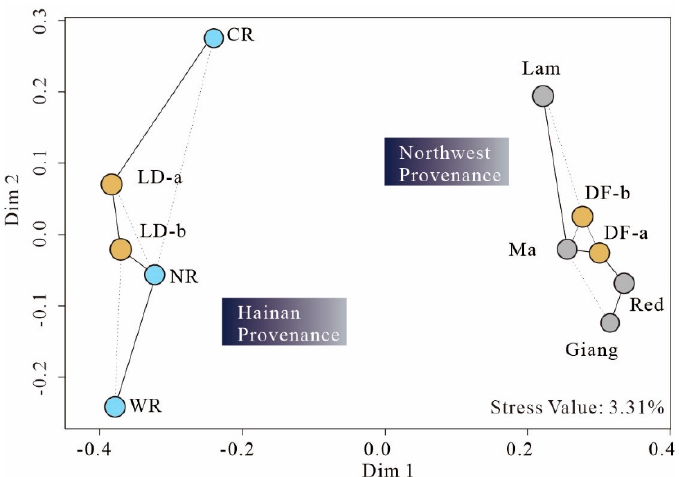
Figure 8. Multidimensional scaling (MDS) plot of detrital zircon U-Pb ages in river and study block sediments. The distance between samples was positively correlated with the Kolmogorov–Smirnov dissimilarity of their dating data. The solid lines connect the nearest neighbors, and the dotted lines link the second nearest samples. The stress value of 3.31% demonstrates an acceptable goodness of fit. The yellow, blue and gray dots represent the borehole samples, Hainan River samples and northwestern river samples, respectively.